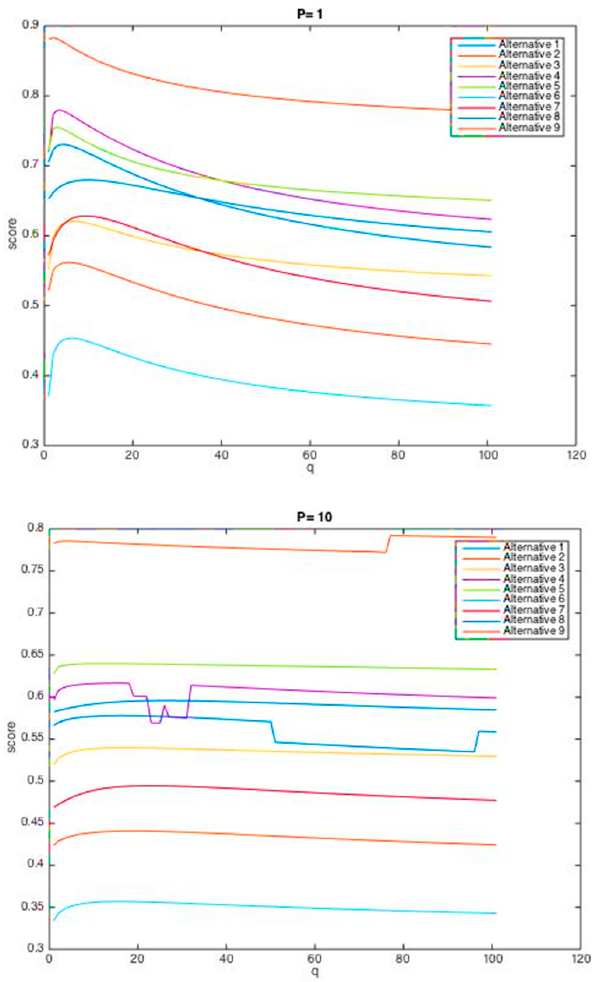
Figure 2. Scores of nine alternatives (q ∈ (0,10]; p = 1, p = 10).